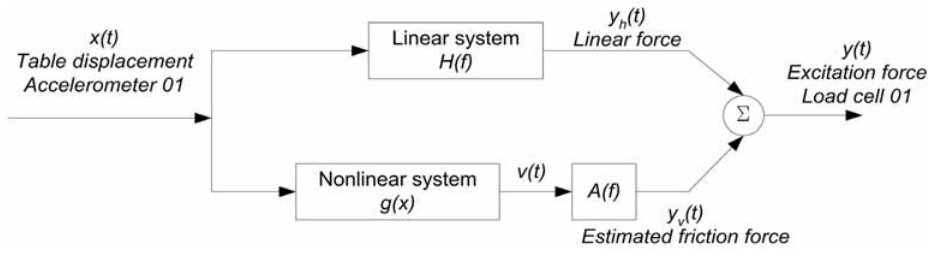
Fig. 9. Vibratory system nonlinear